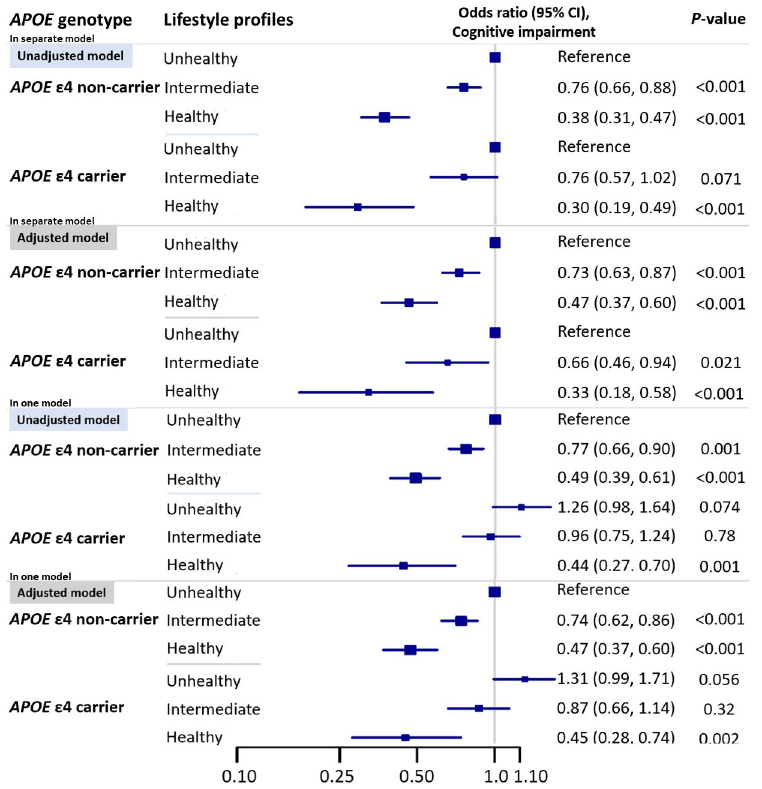
Fig 2. Associations � between cognitive impairment �� and lifestyle profiles stratified by APOE genotype. � Models adjusted for age, sex, residence, education level, marital status, APOE genotype, activity of daily living, and 7 kinds of self-reported disease (COPD, tuberculosis, cancer, diabetes, hypertension, stroke, and cardiovascular disease). �� Cognitive impairment: cognitive impairment was defined by an MMSE score of less than 18. APOE , apolipoprotein E; CI, confidence interval; COPD, chronic obstructive pulmonary disease; MMSE, Mini-Mental State Examination.